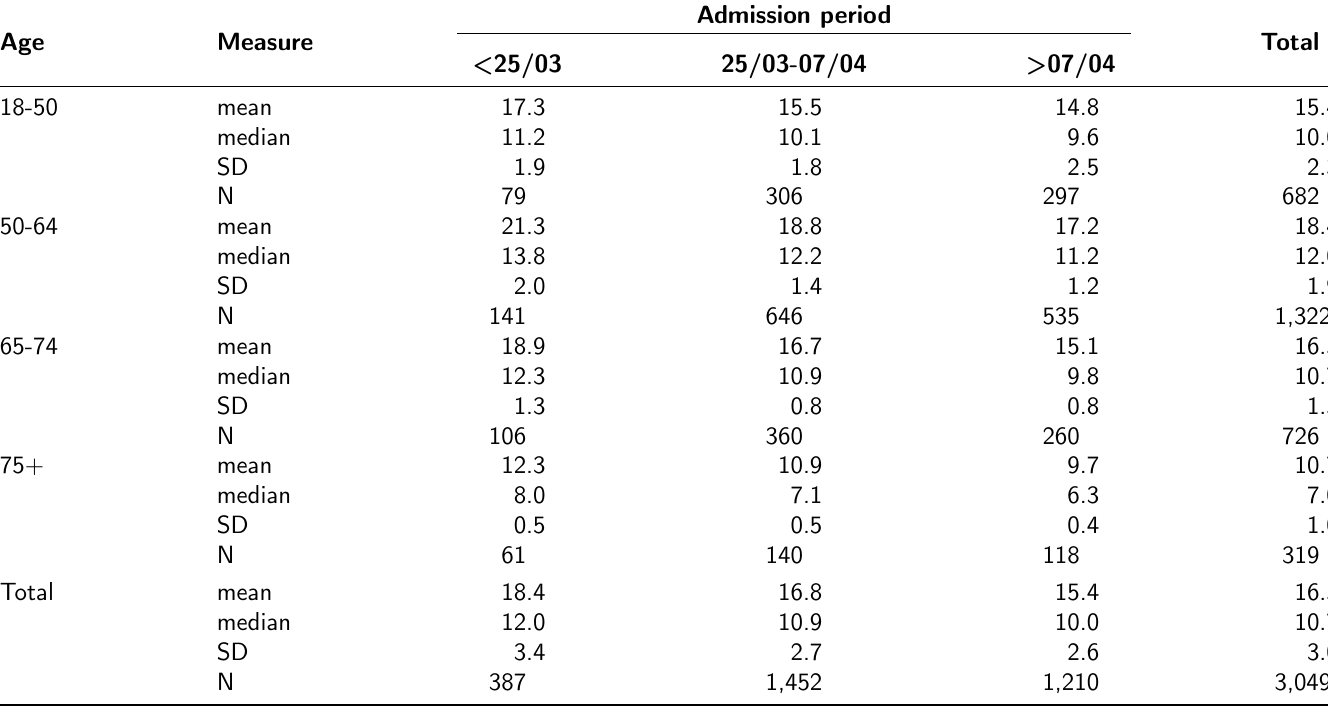
Table 3: Predicted length-of-stay in days based on the log-normal model with main